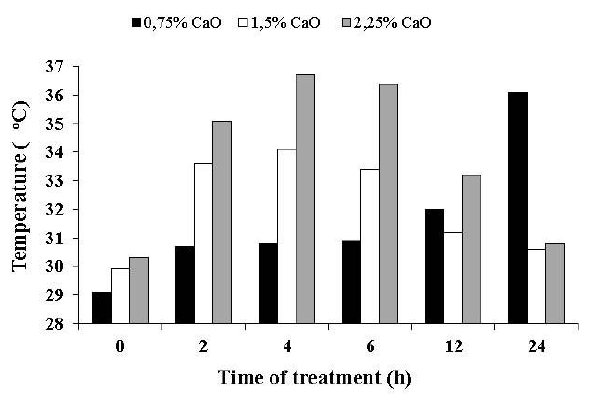
Figure 1. The mean temperature (  C) of sugar cane treated with calcium oxide (CaO, as-fed %) during 24 h of